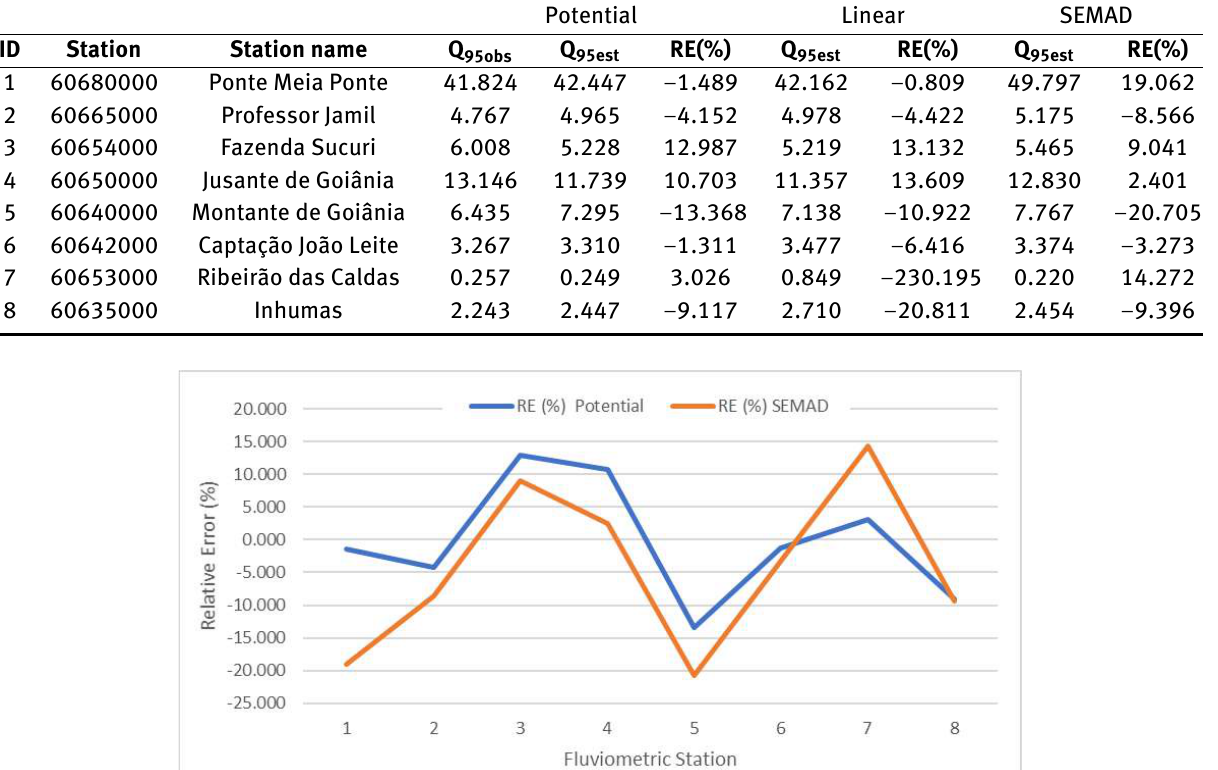
Figure 3: Relative errors (REs) for the application of the potential model and the method used by SEMAD to estimate Q 95 at the eight studied fluviometric